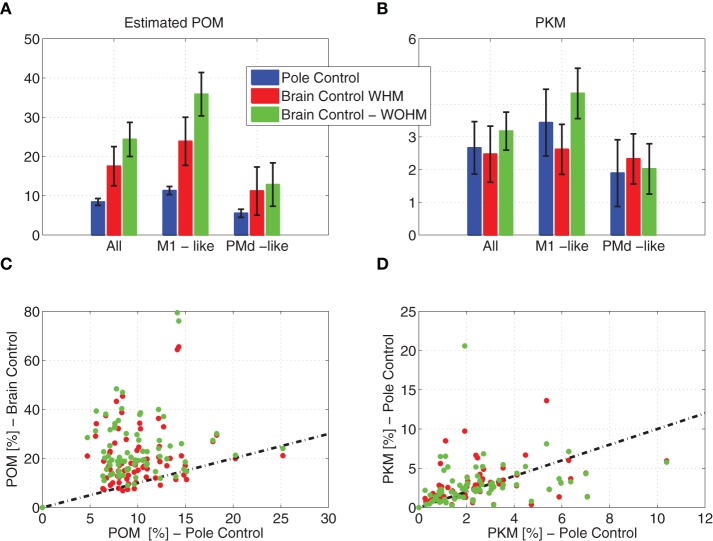
Estimated POM and PKM of simulated neural activity. Estimated POM and PKM were computed by first estimating the POM and PKM of the binned spike-counts of individual neurons in 2-min intervals, and then averaging across the relevant neurons and across the 10 intervals of each control mode. Mean estimated POM (A) and PKM (B) across all neurons and across neurons that encode only the estimated state (PMd-like) or also the control signals (M1-like). Error bars depict the standard deviations across the 10 intervals. Scatter plot of estimated POM (C) and PKM (D) in brain vs. pole control for 78 out of 100 sessions (each with a different set of tuning weights) in which the performance of the BMI filter satisfied 0.65 < R(v^, v) < 0.85. Dashed lines depict the identity relationship.